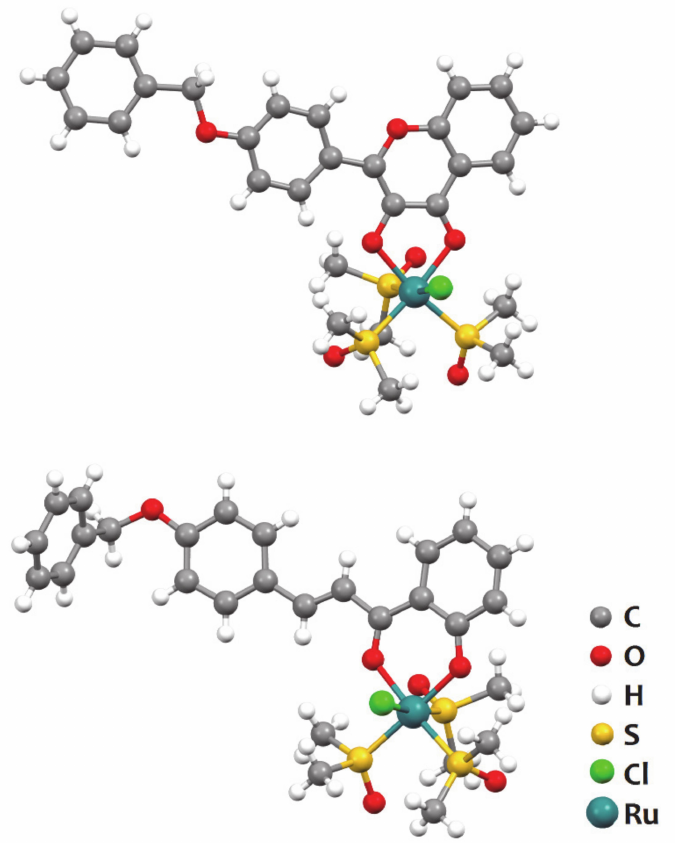
Figure 3. Structure of [Ru(DMSO) 3 (FLVD)Cl], where FLVD is 2-(4-benzyloxy-phenyl)-3hydroxy- chromen-4-one) (top) and [Ru(DMSO) 3 (CHRD)Cl], where CHRD is 3-(4-benzyloxyphenyl)-1-(2- hydroxylphenyl)-prop-2-en-1-one (bottom), represented using the ball-and-stick style. Redrawn from the atomic coordinates available at the CCDC (refcodes TUSTAD and TUSTEH) using the software Mercury